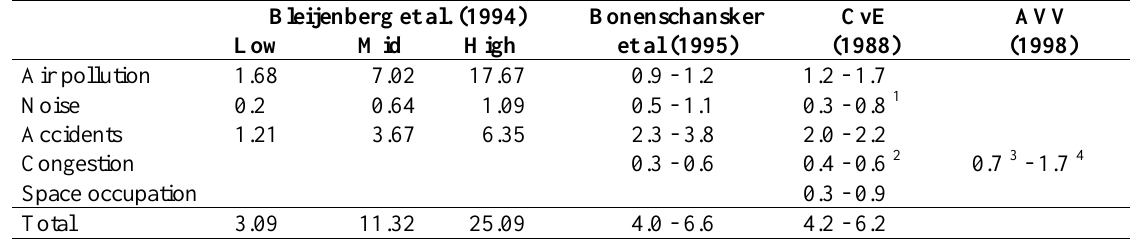
Table 2. Estimates of external costs of road transport in The Netherlands Bleijenberg et al.